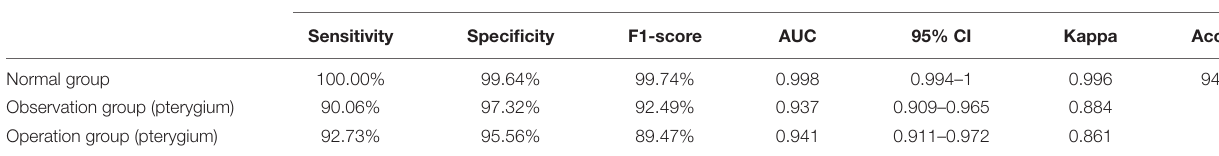
TABLE 2 | Evaluation index results.